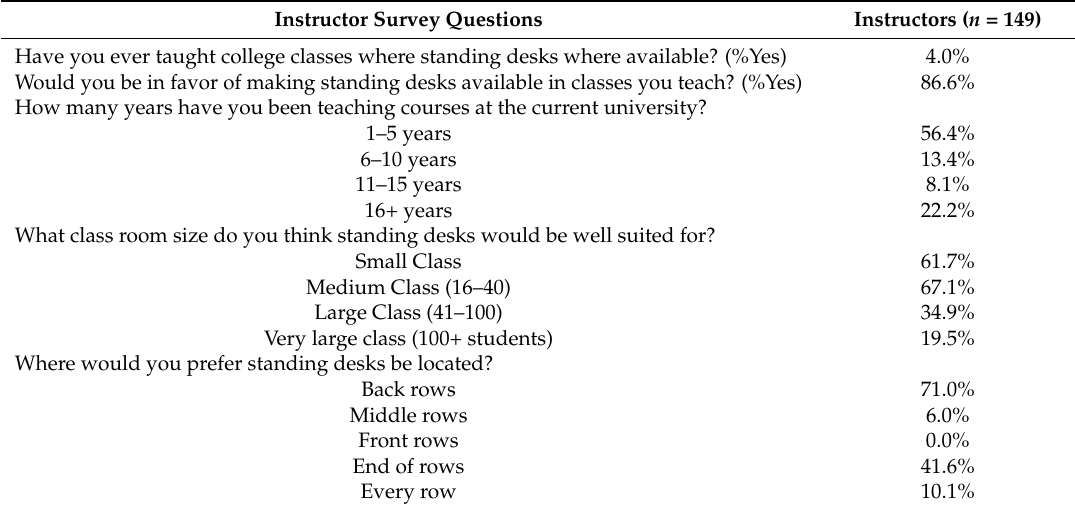
Table 3. Instructor’s perceived acceptability of introducing standing desks.